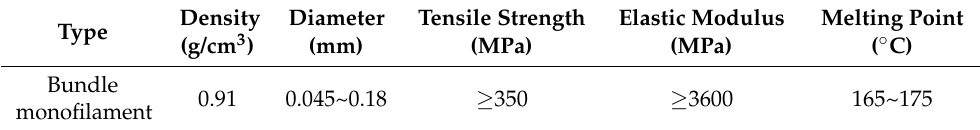
Table 3. Physicomechanical characteristics of polypropylene